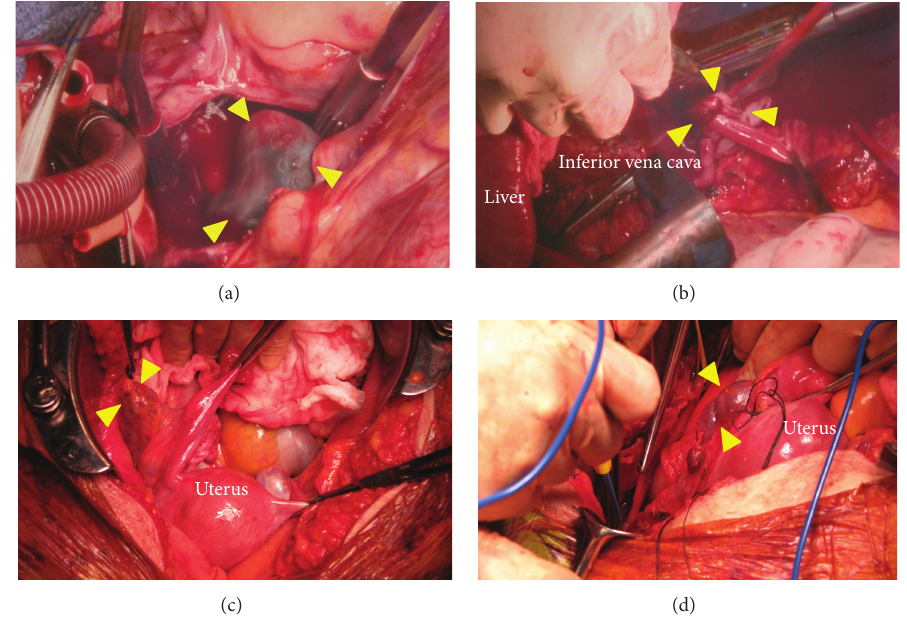
Figure 3: Intraoperative findings. Tumor in (a) the right atrium (arrow heads), (b) the inferior vena cava (arrow heads), (c) the right ovarian vein (arrow heads), and (d) the right uterine vein (arrow